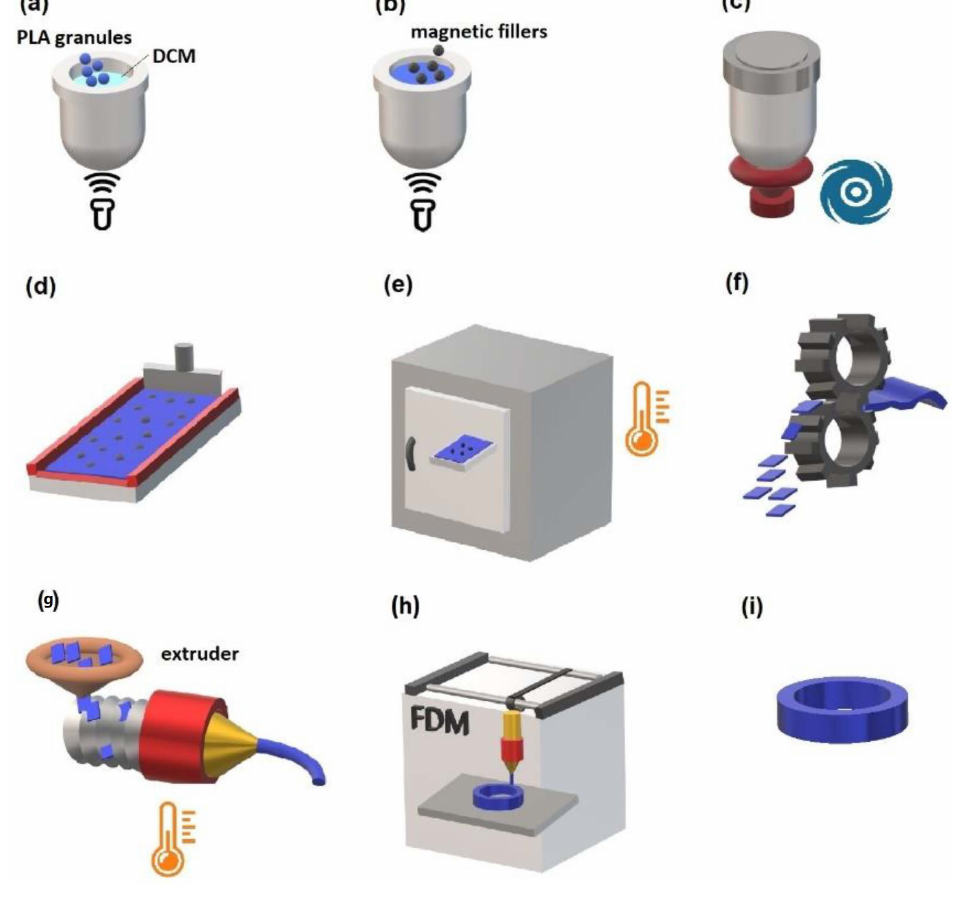
Figure 1. Schematic representation of a PLA-based composite magnetic filament preparation for FDM printing: ( a ) preparation of the PLA solution; ( b ) filler addition; ( c ) homogenization; ( d ) composite film preparation; ( e ) drying; ( f ) pelletizing; ( g ) extrusion; ( h ) FDM printing of the object; ( i ) final